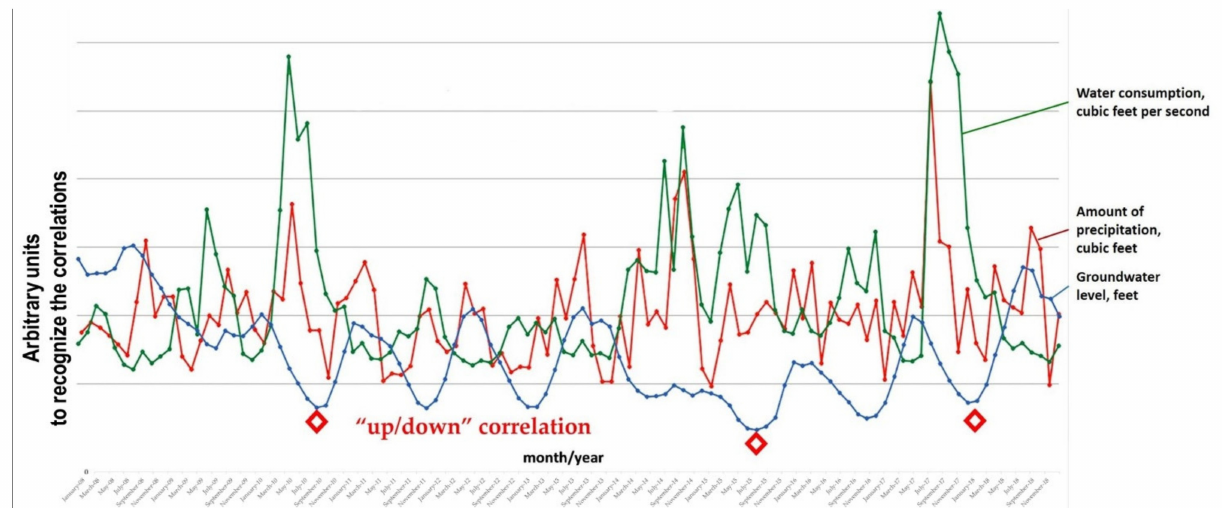
Figure 13. Statistics for the Santee River, South Carolina (“up/down” correlation for water consump- tion and groundwater showing the local reduction of underground reserves due to flooding). On the horizontal axis–the data by year/month. On vertical axes–volumes of water for precipitation (in cubic feet), water consumption (in cubic feet per second) and groundwater level (in feet). Red diamonds mean a noticeable anticorrelation of groundwater level with water masses in the form of precipitation and water